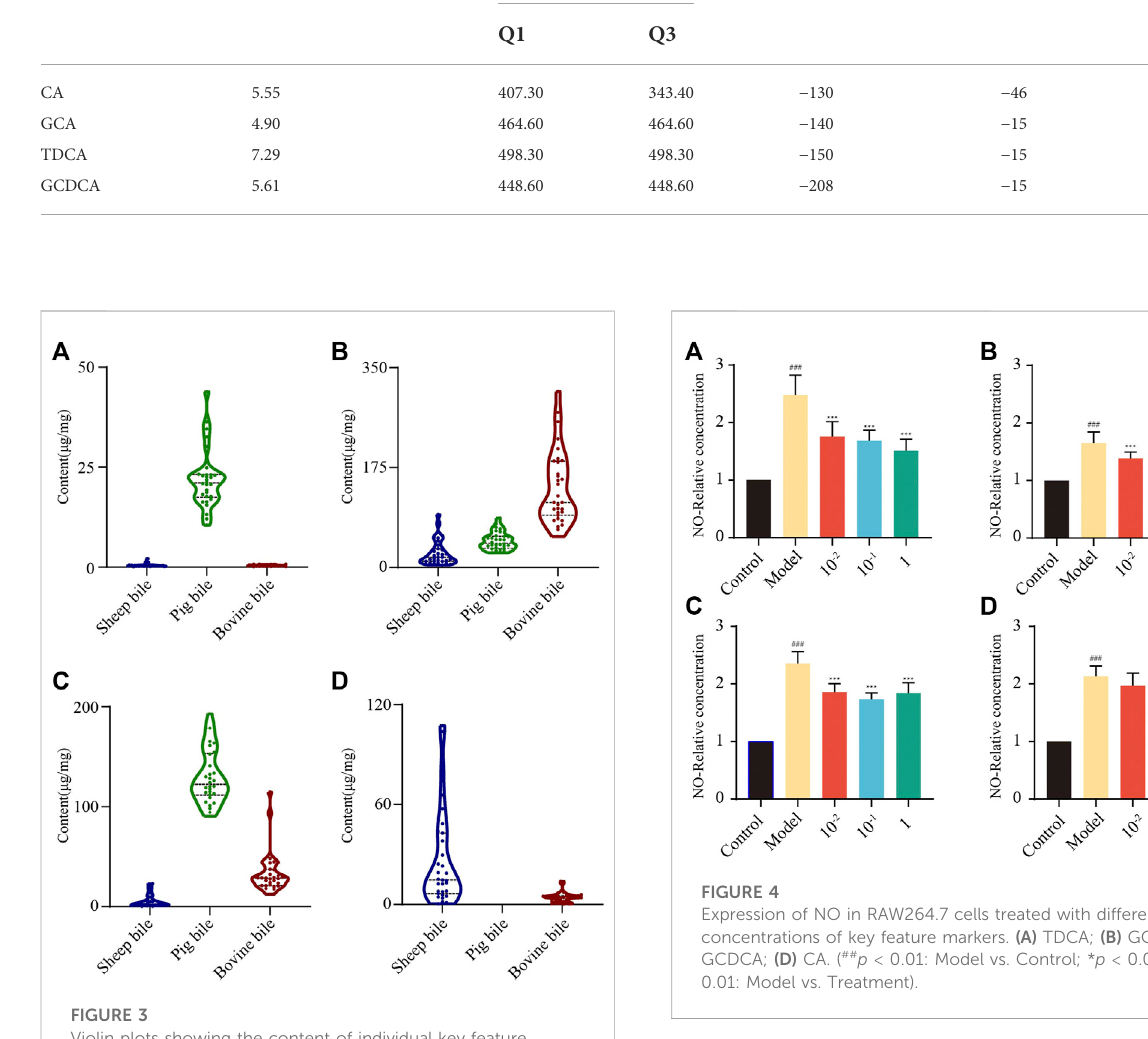
FIGURE 3 Violin plots showing the content of individual key feature marker in samples of bile from three animals. (A) TDCA; (B) GCA; (C) GCDCA; (D) CA.